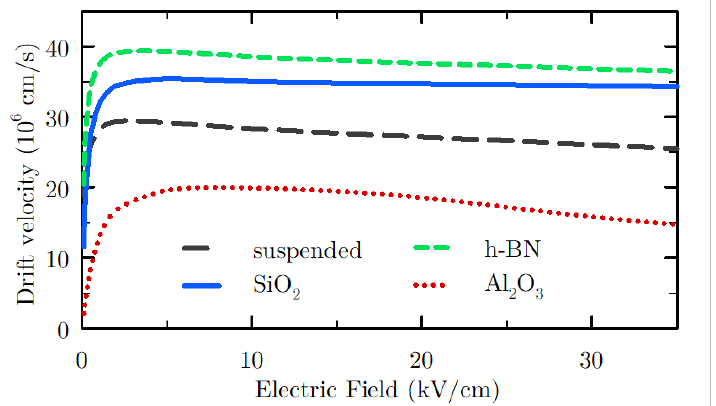
Figure 2. Drift velocity versus applied electric field curves for samples of suspended graphene and graphene on different substrates for T = 300